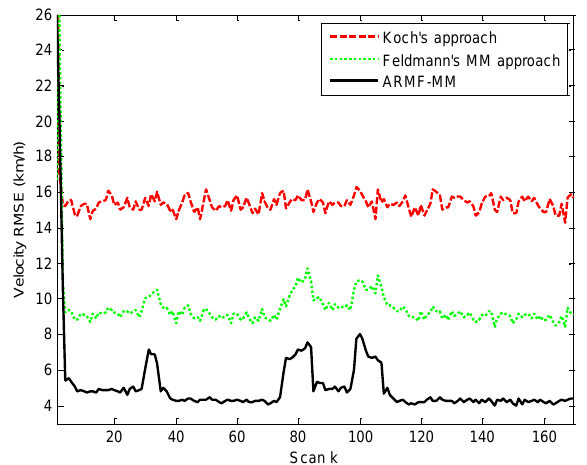
Figure 8. RMSE of velocity in simulation scenario 2.